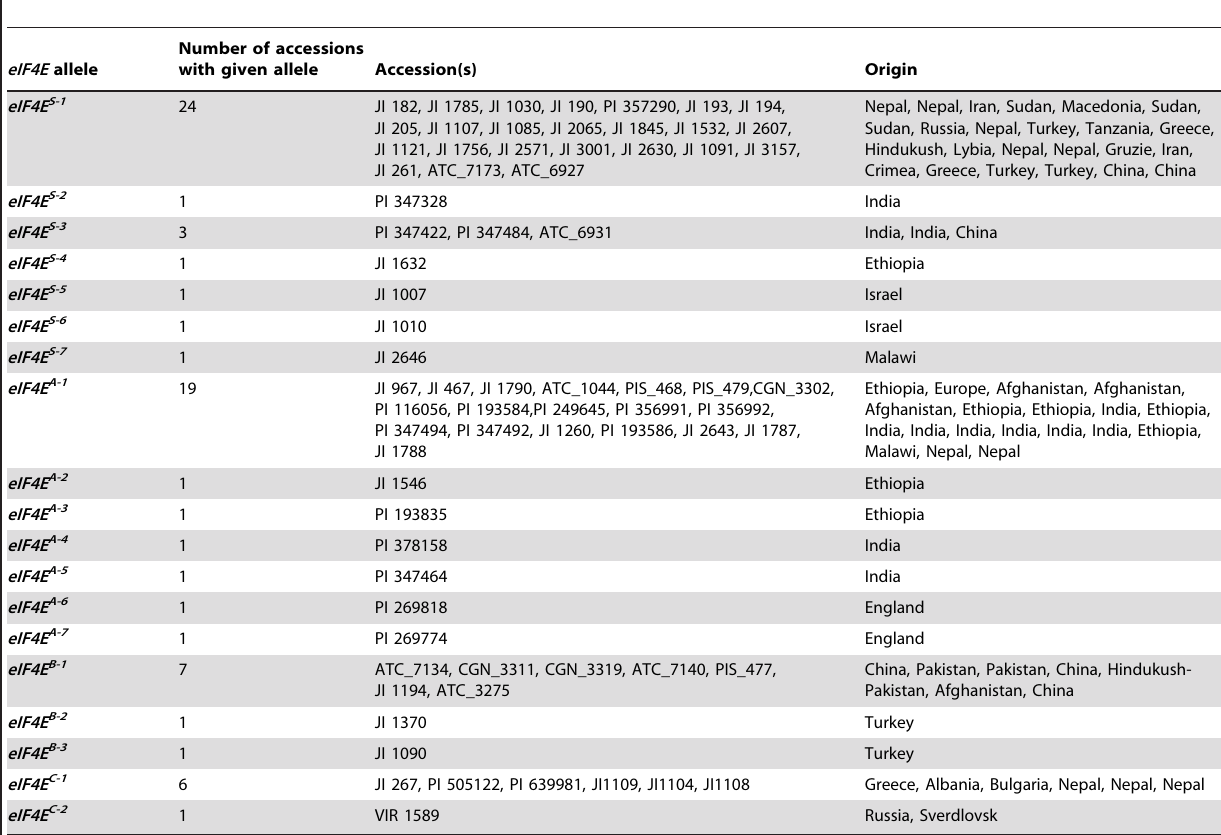
Table 3. List of sequenced 73 accessions assigned to identified 19 protein alleles of four eIF4E A-B-C-S intron 3 length variants with indicated country of